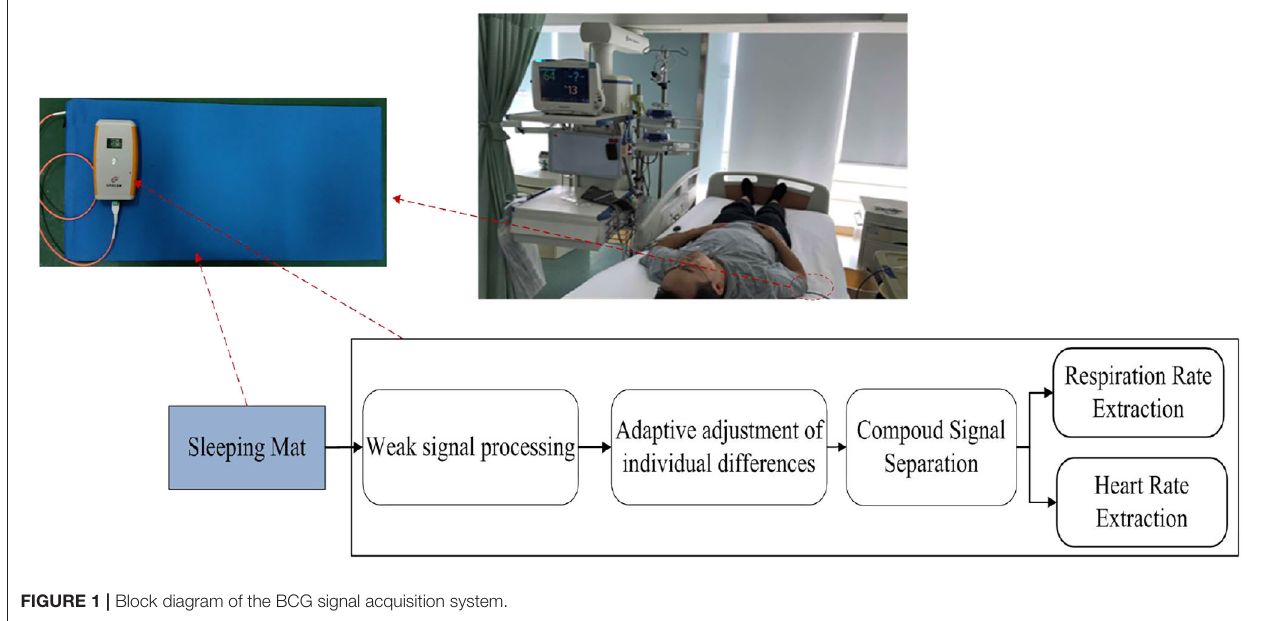
FIGURE 1 | Block diagram of the BCG signal acquisition system.